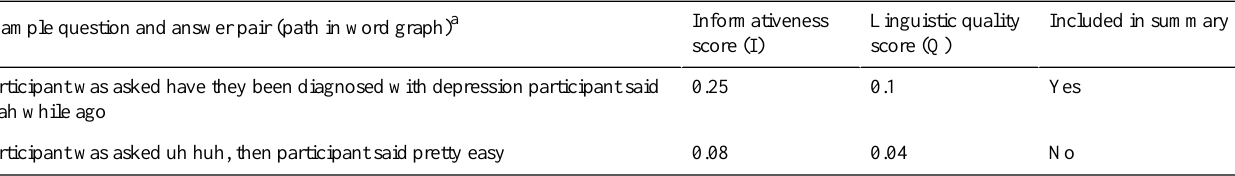
Included in summaryLinguistic quality